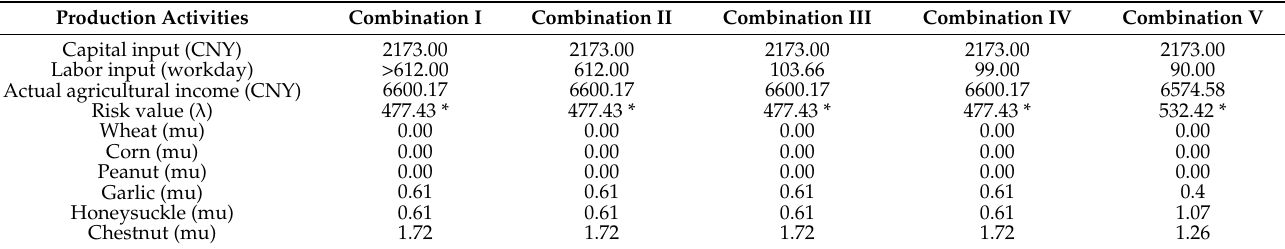
Table 13. Optimization of labor input for NAPH